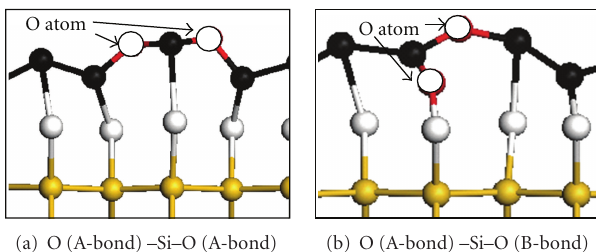
Figure 4: Cross sections of stable structures with absorption of two O atoms at (a) O (A-bond) –Si–O (A-bond) and (b) O (A-bond) –Si–O (B-bond). Black (white) balls indicate the Si atoms in the first (second) layer. O atoms are indicated in each figure. The coverage ratio R ox = 0 . 10.